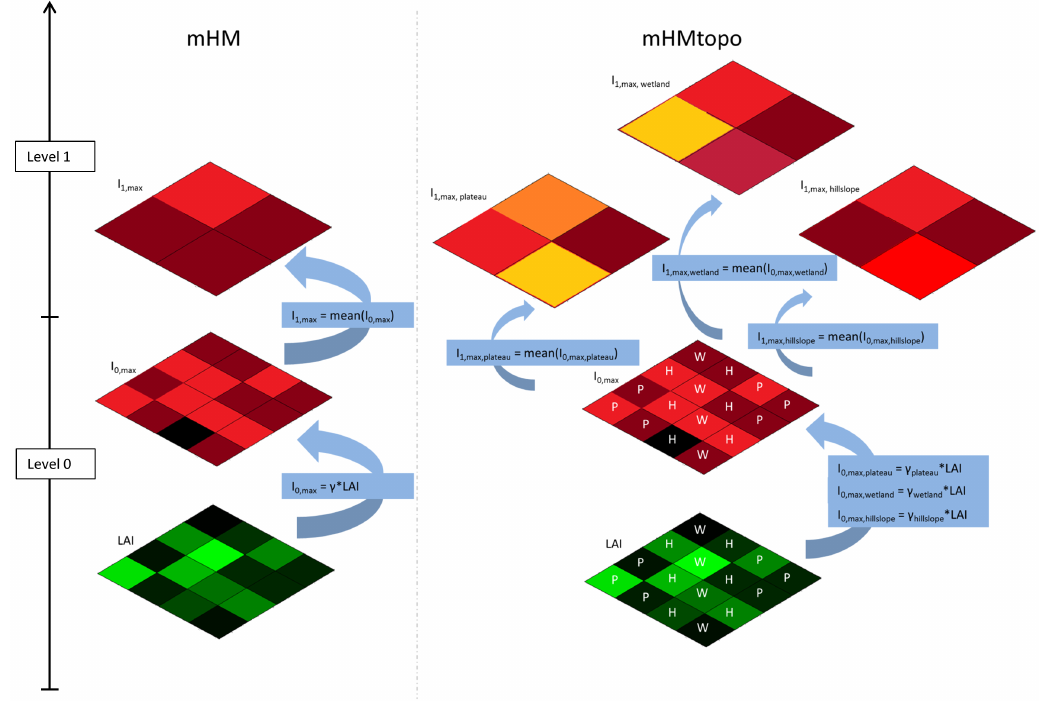
Figure 5. Schematic representation of the original MPR (left) and the adjusted MPR (right) for the maximum interception capacity ( I 1 , max ). On the input level 0, the leaf area index (LAI) is linked through the global, generally valid, parameter γ with I 0 , max . In a last step, the mean is used for upscaling, yielding I 1 , max at the modelling resolution. For mHMtopo, the functional relations are the same, but plateau (P), hillslope (H) and wetland (W) have their own global parameters γ . The upscaling is subsequently carried out over each landscape class within each grid cell. This leads to the interception capacities of plateau, hillslope and wetland ( I 1 , max , plateau , I 1 , max , hillslope and I 1 , max , wetland